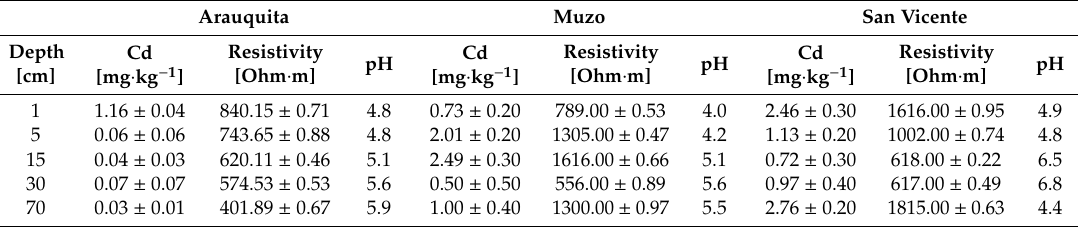
Table 1. Pseudo-total Cd content [mg · kg − 1 ], resistivity [Ohm · m] and soil pH of composite soil samples collected per boundary of the pits dug in the municipalities of Arauquita, Muzo, and San Vicente de Chucur í . Data are shown as an average of the farms assessed per municipality. Both Cd and resistivity values are shown as mean ±